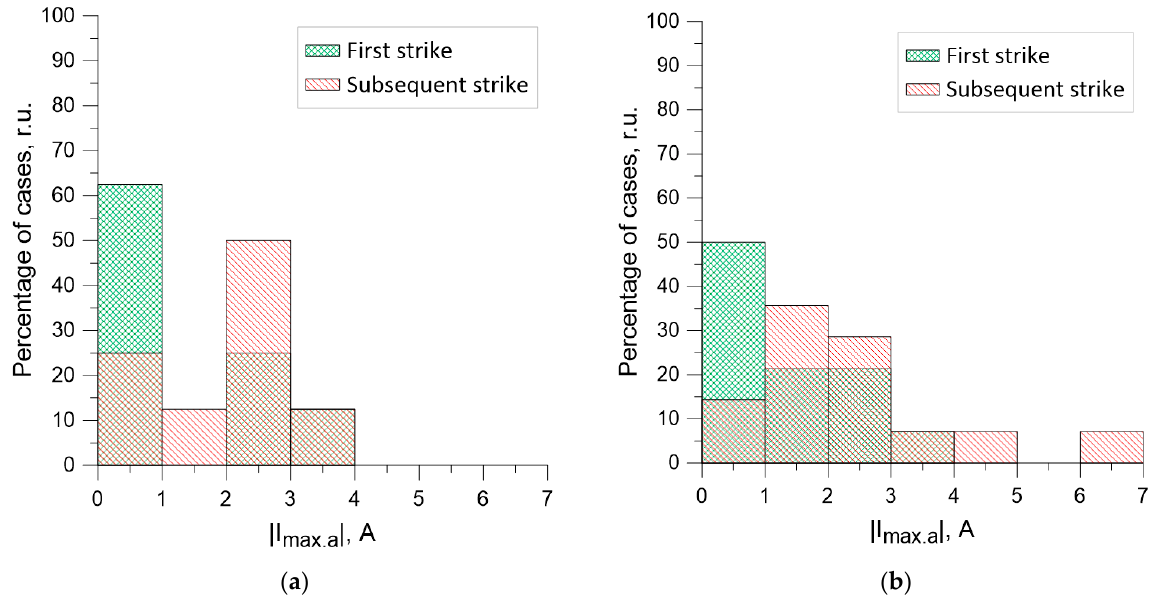
Figure 15. Distribution of signal amplitude values of Imax.a, induced at the antenna A3 by the first and repeated discharges: ( a )—variant in Figure 2c; ( b )—variant in Figure 2d.